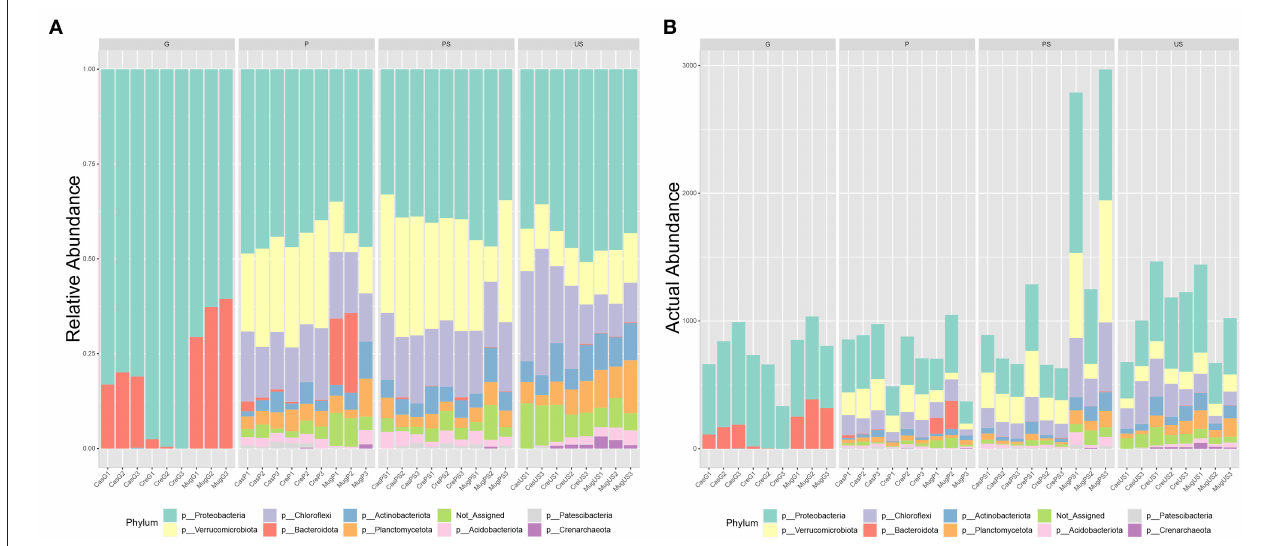
FIGURE 2 | Barplots of detected OTUs at the phylum level. The percentage of detected phyla (A) and the actual abundance (B) in the four tested sample types are reported. Samples are grouped according to collection site (Cas, casentino; Cre, crete senesi; Mug, mugello) then to the truffle sample type (P, peridium; G, gleba) or the soil sample type (PS, productive soils; US, unproductive soils).